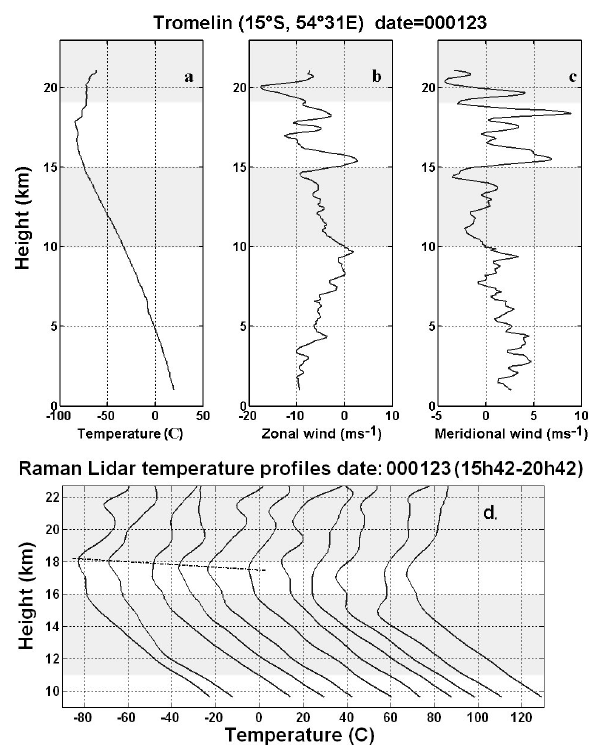
Figure 1. Vertical profiles of (a) temperature, (b) zonal wind and (c) meridional wind at Tromelin Island and (d) successive 30-min integrated vertical profiles of temperature with 150-m spatial resolution produced by a Raman lidar at La Réunion between 1542 and 2042 on 23 January 2000. The dash-dotted lines and grey areas indicate a downward phase progression and height ranges respectively for gravity-wave analysis.